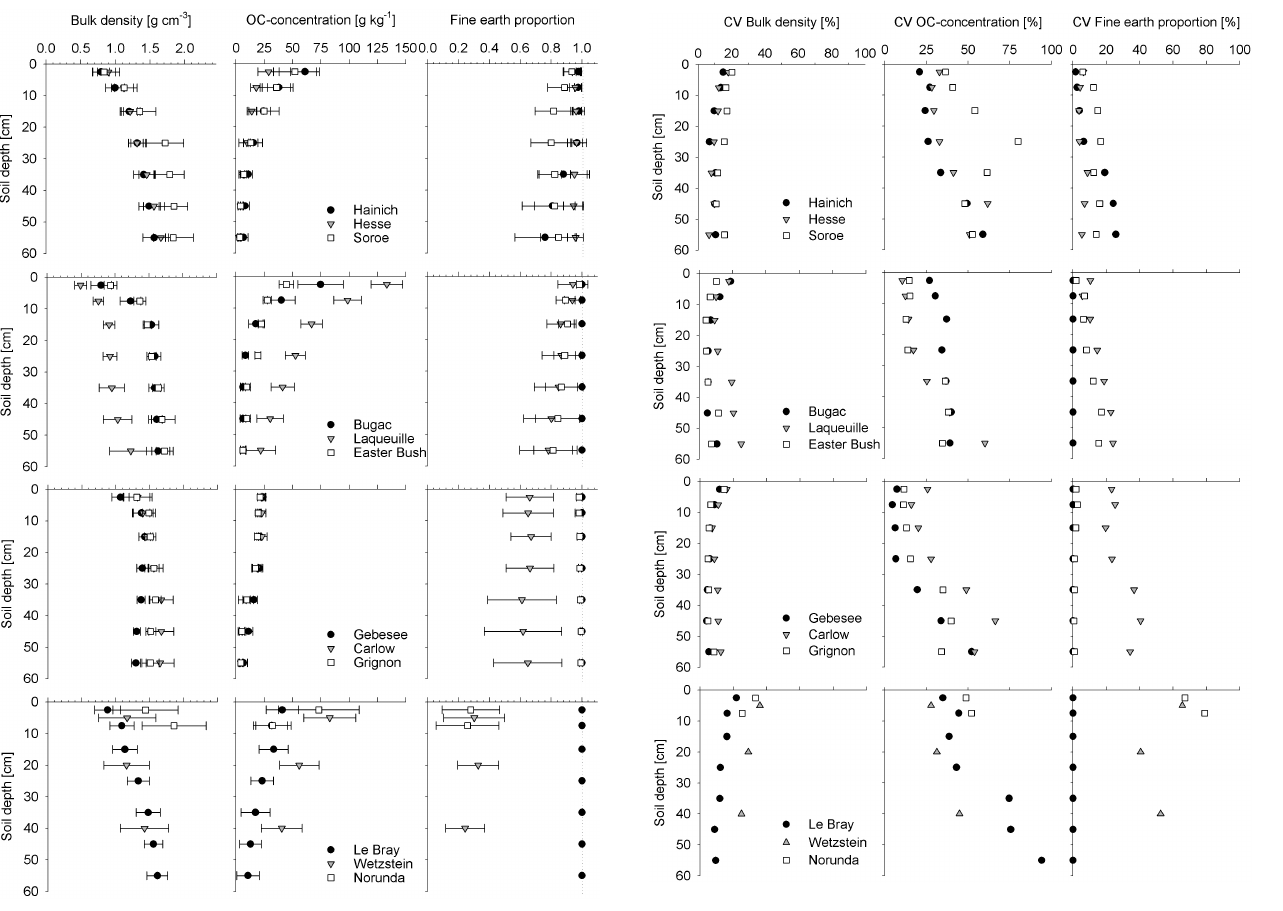
Fig. 3. Coefficients of variation for soil bulk densities, OC concen- trations, and the fine earth contents at different soil depths at the study